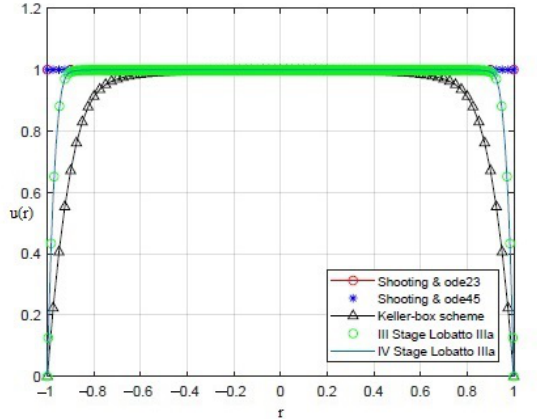
Figure 3. Recovering of u ( r ) for δ = 0 and θλ 2 as reported in Tables 1 and 2.